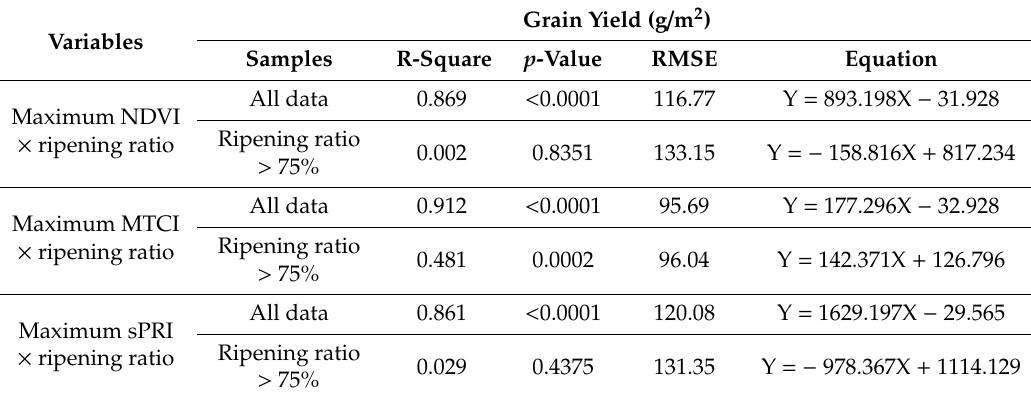
Table 4. Statistical results on grain yield estimated from two values of vegetation index and the ripening ratio. The maximum vegetation index refers to the maximum value of vegetation index during the paddy rice growth